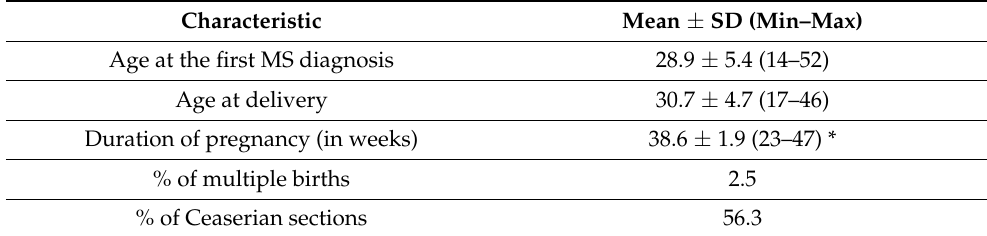
Figure 1. Scheme of study samples selection. Table 1. Characteristics of deliveries of MS patients ( n = 2876).